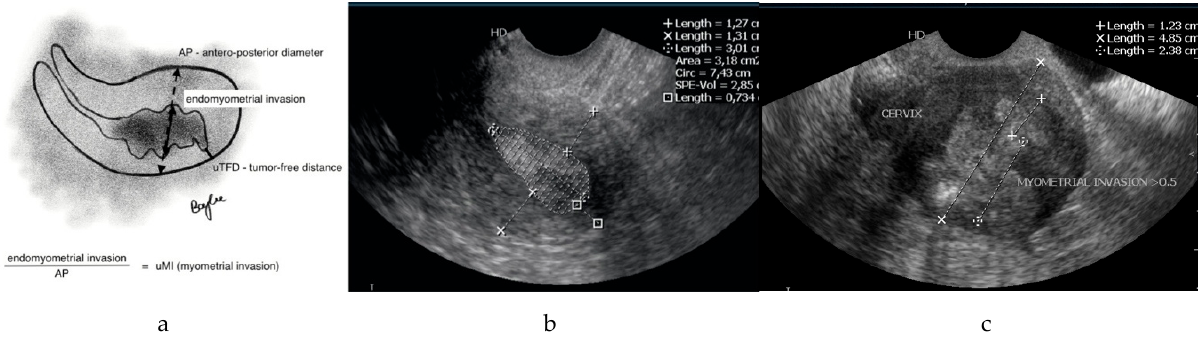
Figure 1. The measurements of infiltration depth (uMI) and tumor-free muscle thickness (uTFD) on transvaginal ultrasound: ( a ) graphic representation of measurements of the uMI and uTFD; ( b ) ultrasound sagittal image with the measurement of uTFD (between squares, >5.2 mm—low risk of LNM), marking the area of tumor infiltration with the measurement of the thickness of free walls; MI clearly <0.5—low risk of LNM; ( c ) ultrasound sagittal image of significant tumor invasion, MI much more than 0.5, uTFD unmeasurable (area of lowest measuring point on the photograph, the infiltration reaches the sub serosa); high risk of LNM.